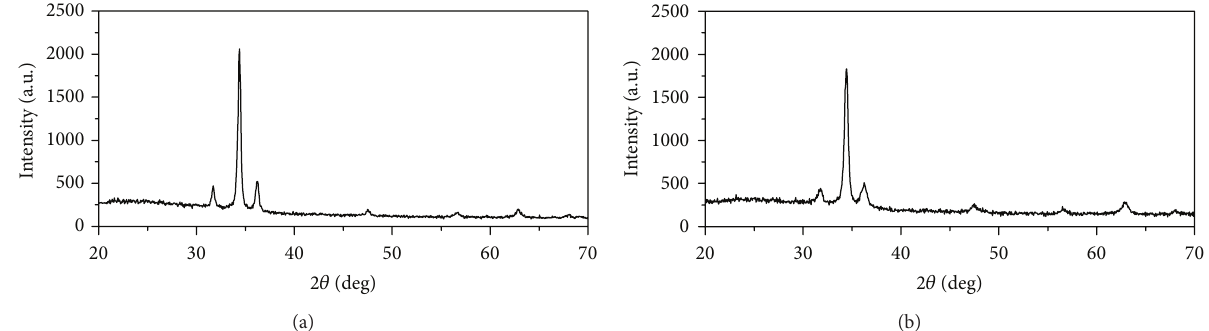
Figure 1: X-ray diffraction pattern of (a) undoped ZnO and (b) 1% AZO film.